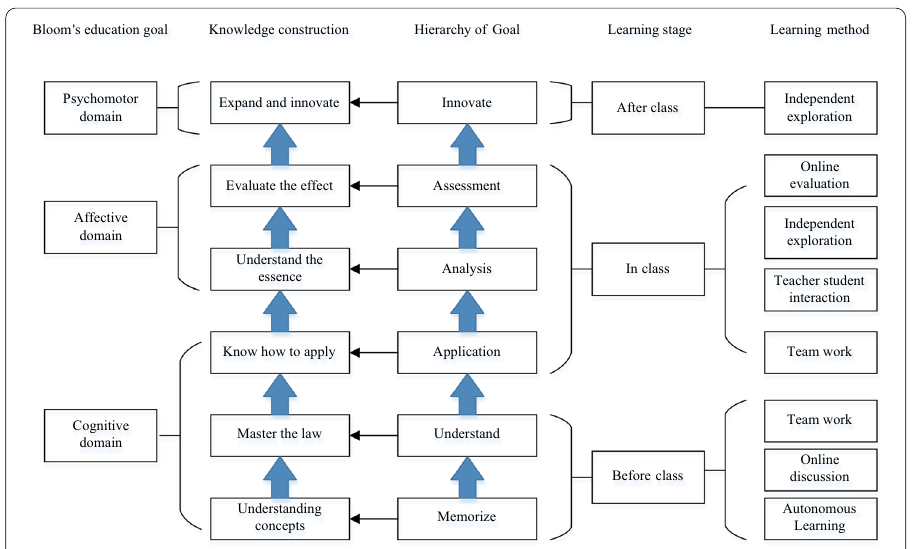
Fig. 3 Teaching design based on Bloom’s education goal